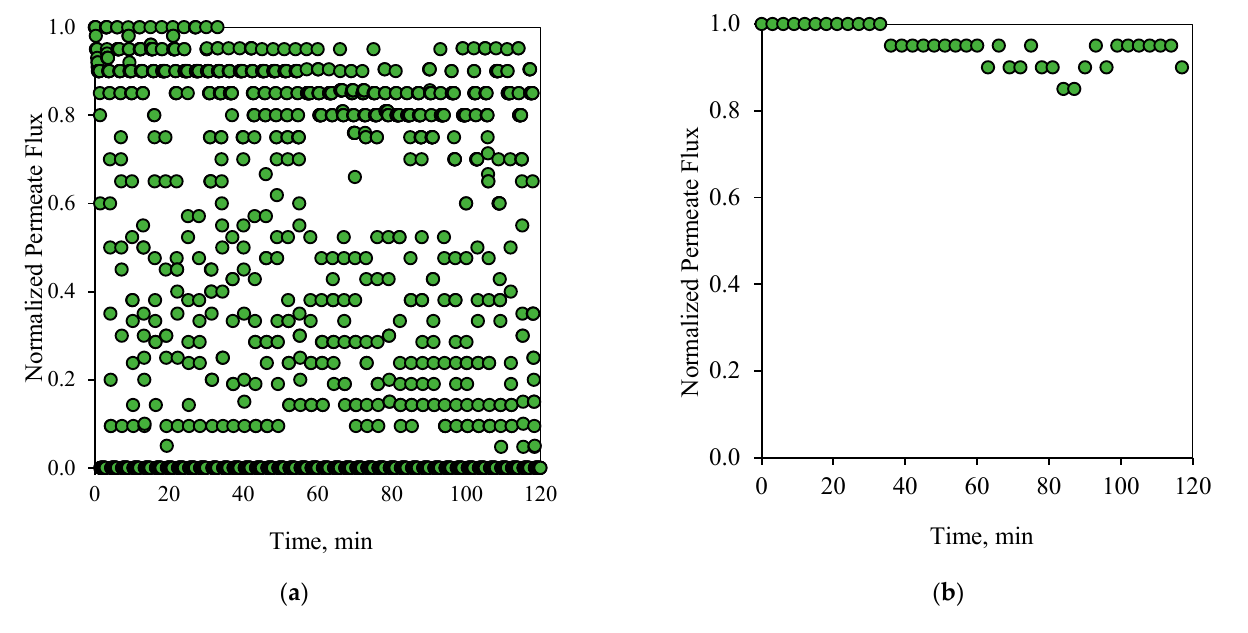
Figure 9. Permeate flux profile using the 1-2 PFPT for a feed of 200 ppm at CFV: 1 m/s: ( a ) 2 h of filtration operation, ( b ) membrane permeability after each cleaning half-cycle.